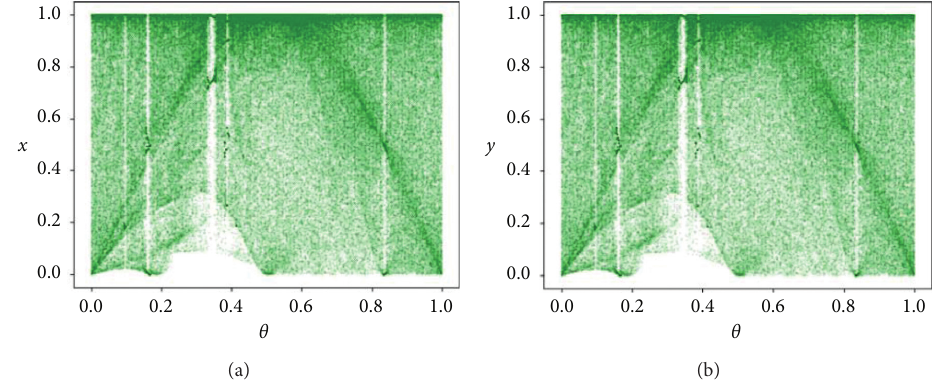
Figure 1: The bifurcation diagram of 2D-LSCM. (a) θ − x ; (b) θ − y